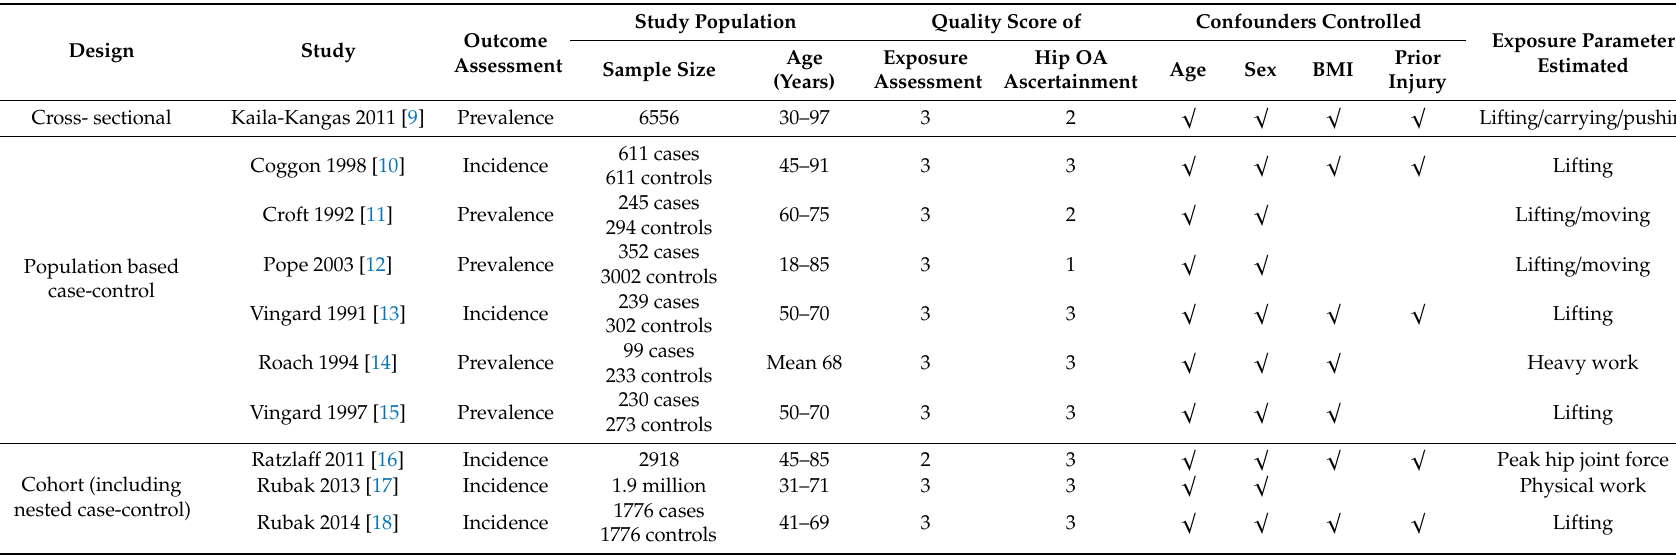
Table 3. Design and methodological quality of studies stating a dose–response relationship between heavy lifting and the risk of hip osteoarthritis.